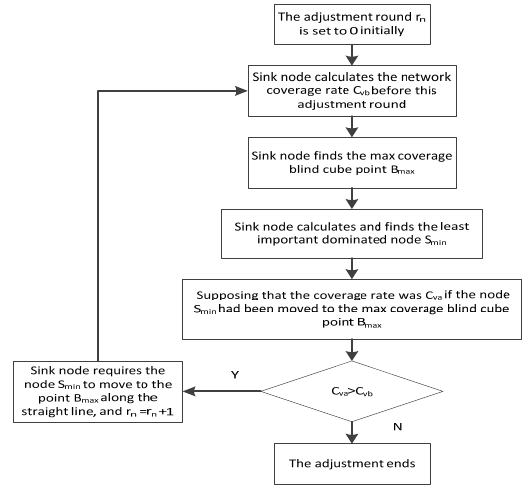
Figure 3. Adjustment process for the locations of dominated nodes by sink node.